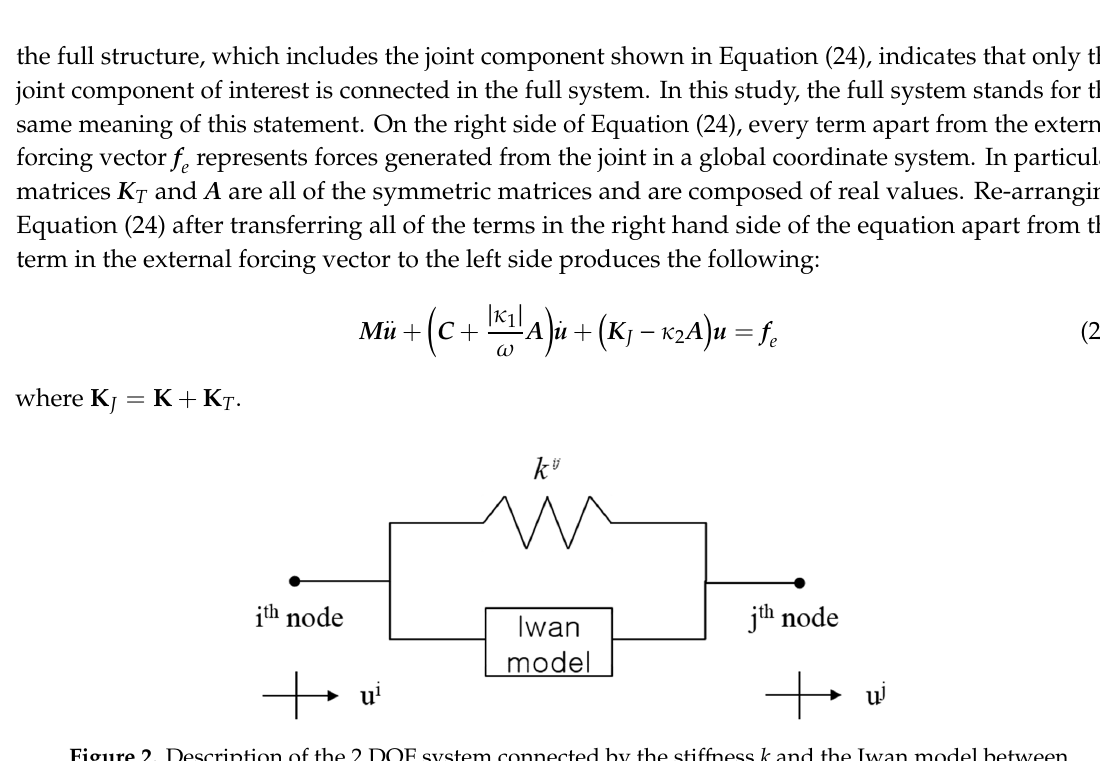
Figure 2. Description of the 2 DOF system connected by the stiffness k and the Iwan model between the i th and j th nodes.